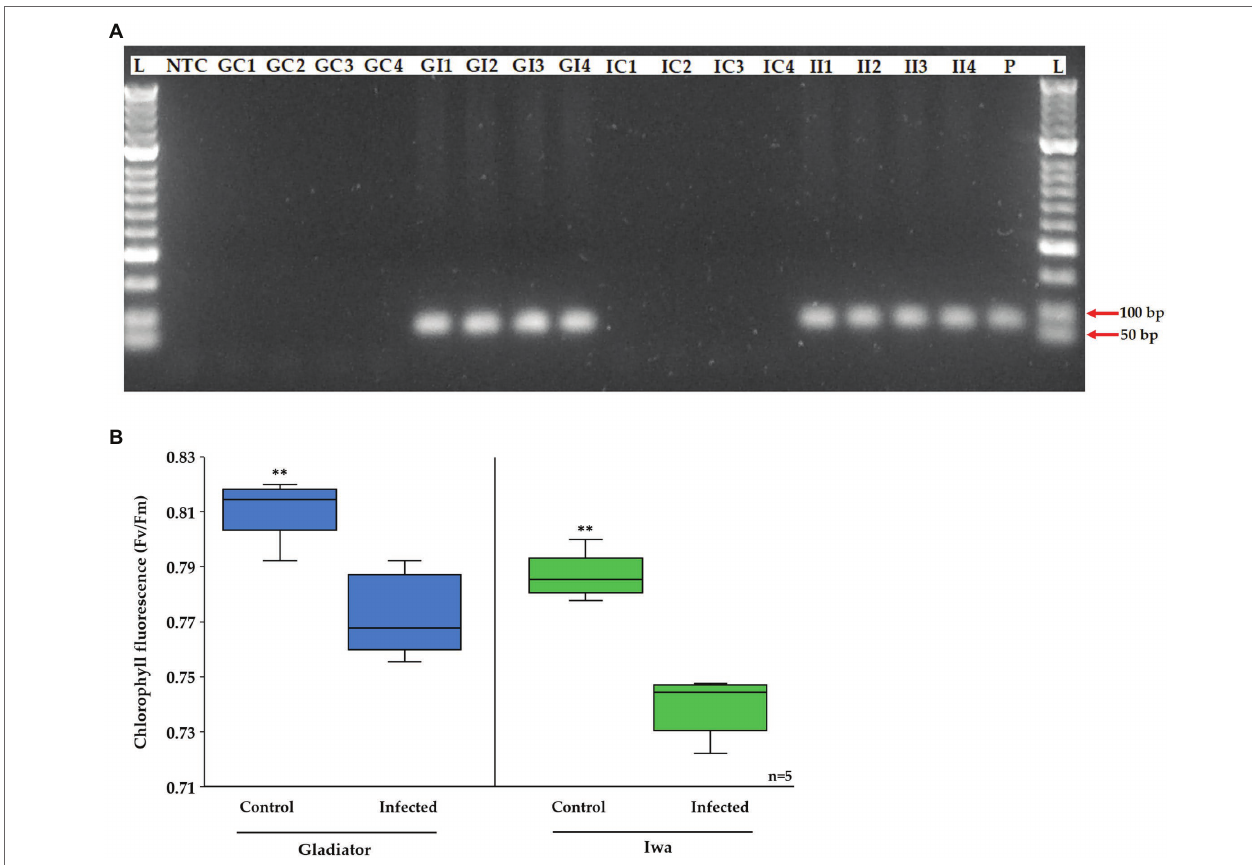
FIGURE 1 | (A) Agarose gel electrophoresis of the PCR product of Spongospora subterranean 18S rRNA gene for DNA extracted from potato roots of inoculated and control plants. Lane M, MassRuler DNA ladder; lane NTC, non-template control; lane P, positive control; GC, Gladiator control; GI, Gladiator inoculated; IC, Iwa control; and II, Iwa inoculated. (B) Effect of potato root infection by S. subterranean on chlorophyll fluorescence. Values are means ± SE ( n = 5 independent plants). Asterisk (**) indicate a significant difference at p <